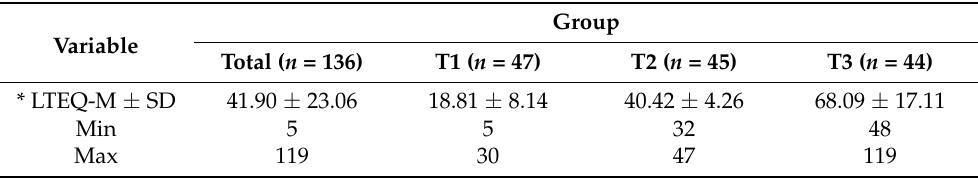
Table 1. Reported level of physical activity under